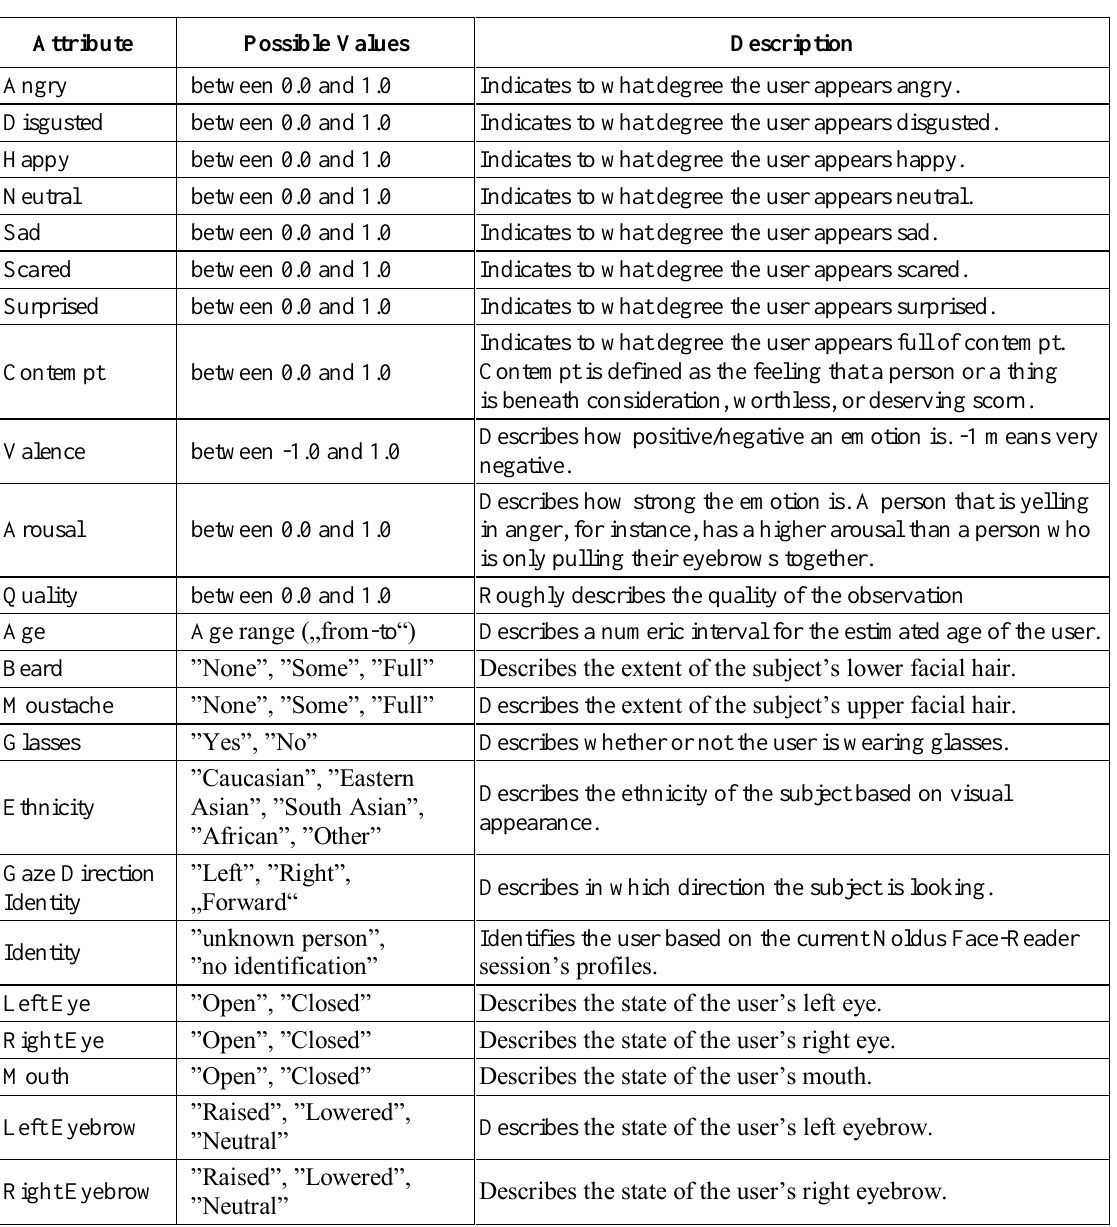
Table 2. Input data from emotion